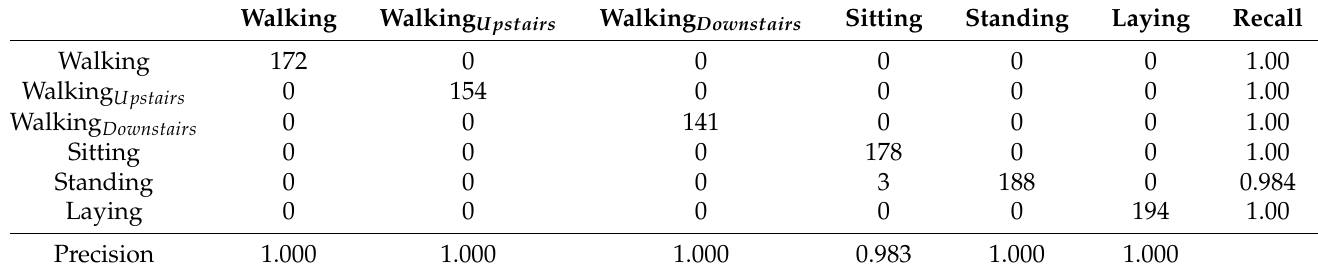
Table 12. Confusion Matrix for the proposed 4-layer